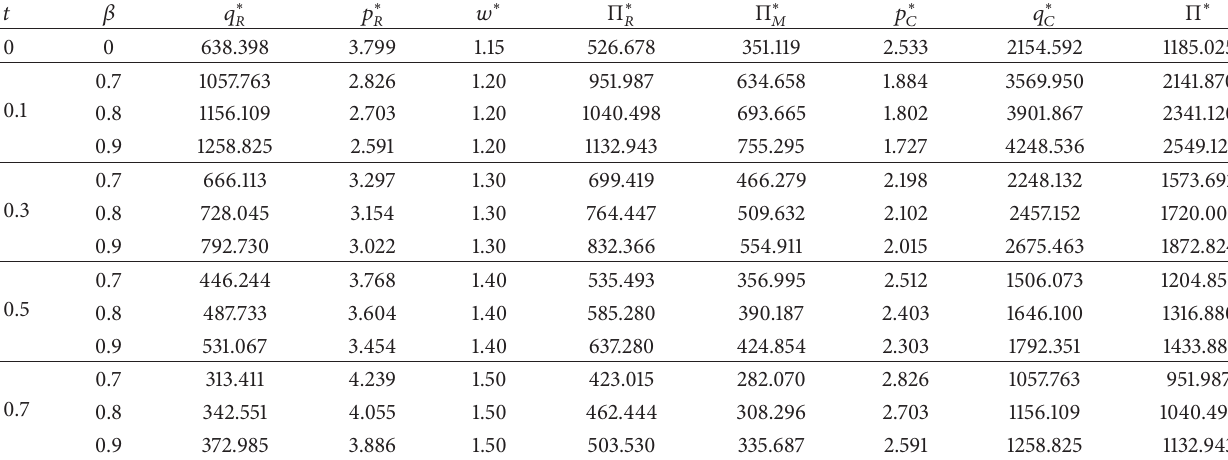
Table 5: The optimal decisions and profits with varying 𝑡 and 𝛽